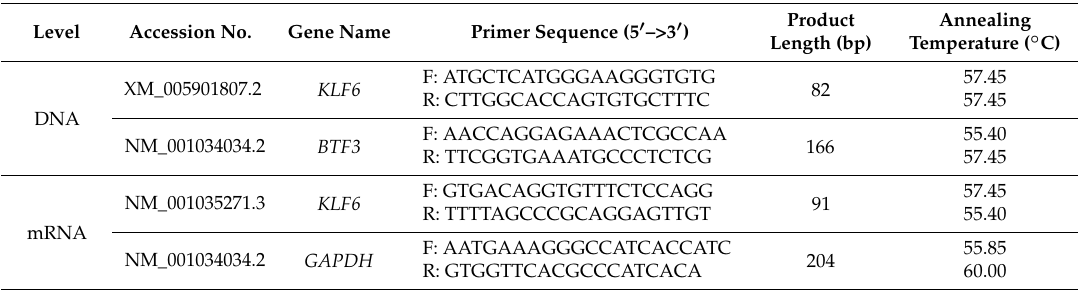
Table 1. qPCR primers designed based on bovine genomic